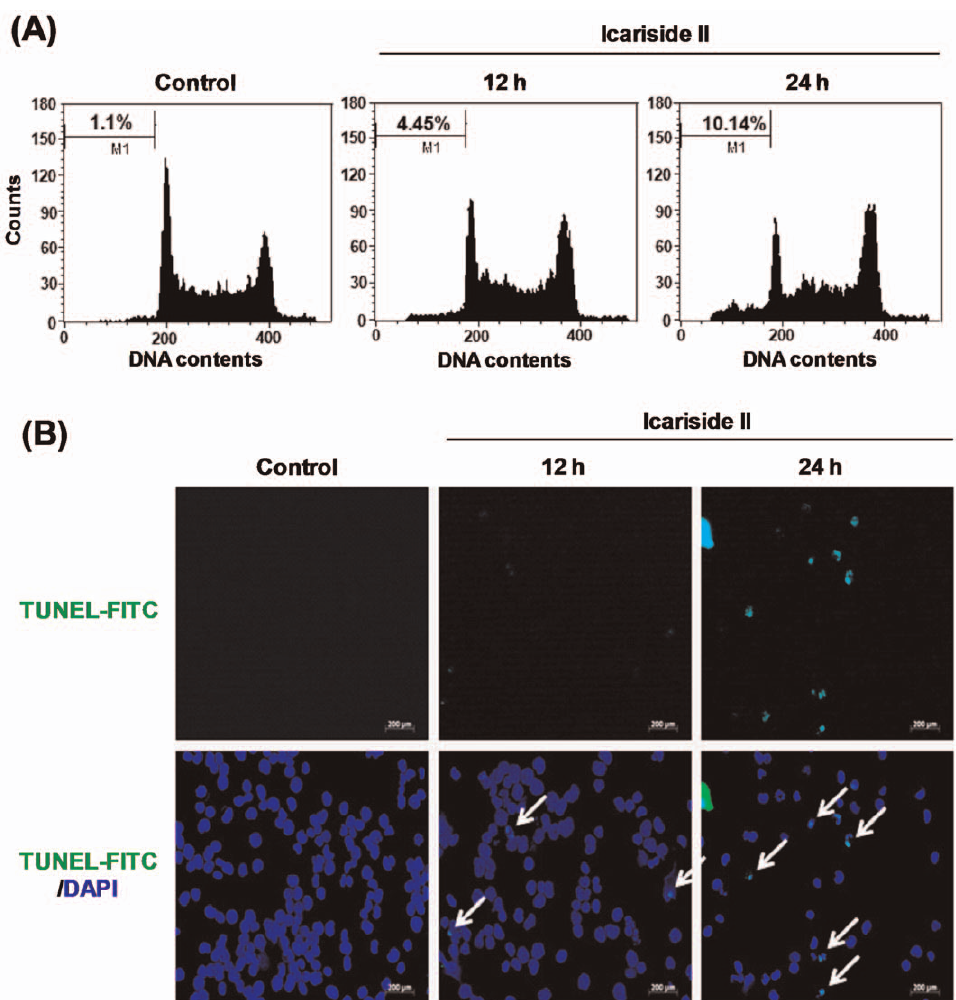
Figure 2. Effect of Icariside II on apoptosis induction in U937 cells. Cells were treated with Icariside II (50 m M) for 24 h. (A) The treated cells were fixed with 70% ethanol, stained with propidium iodide (PI) and analyzed the sub-G1 apoptotic cells by flow cytometry. (B) TUNEL staining was performed by using Dead End TM fluorometric TUNEL assay kit (Promega) and visualized under fluorescence microscopy ( 6 200). Arrows indicate TUNEL (FITC)-stained cells. Representative results of three independent experiments are shown for each experiment.